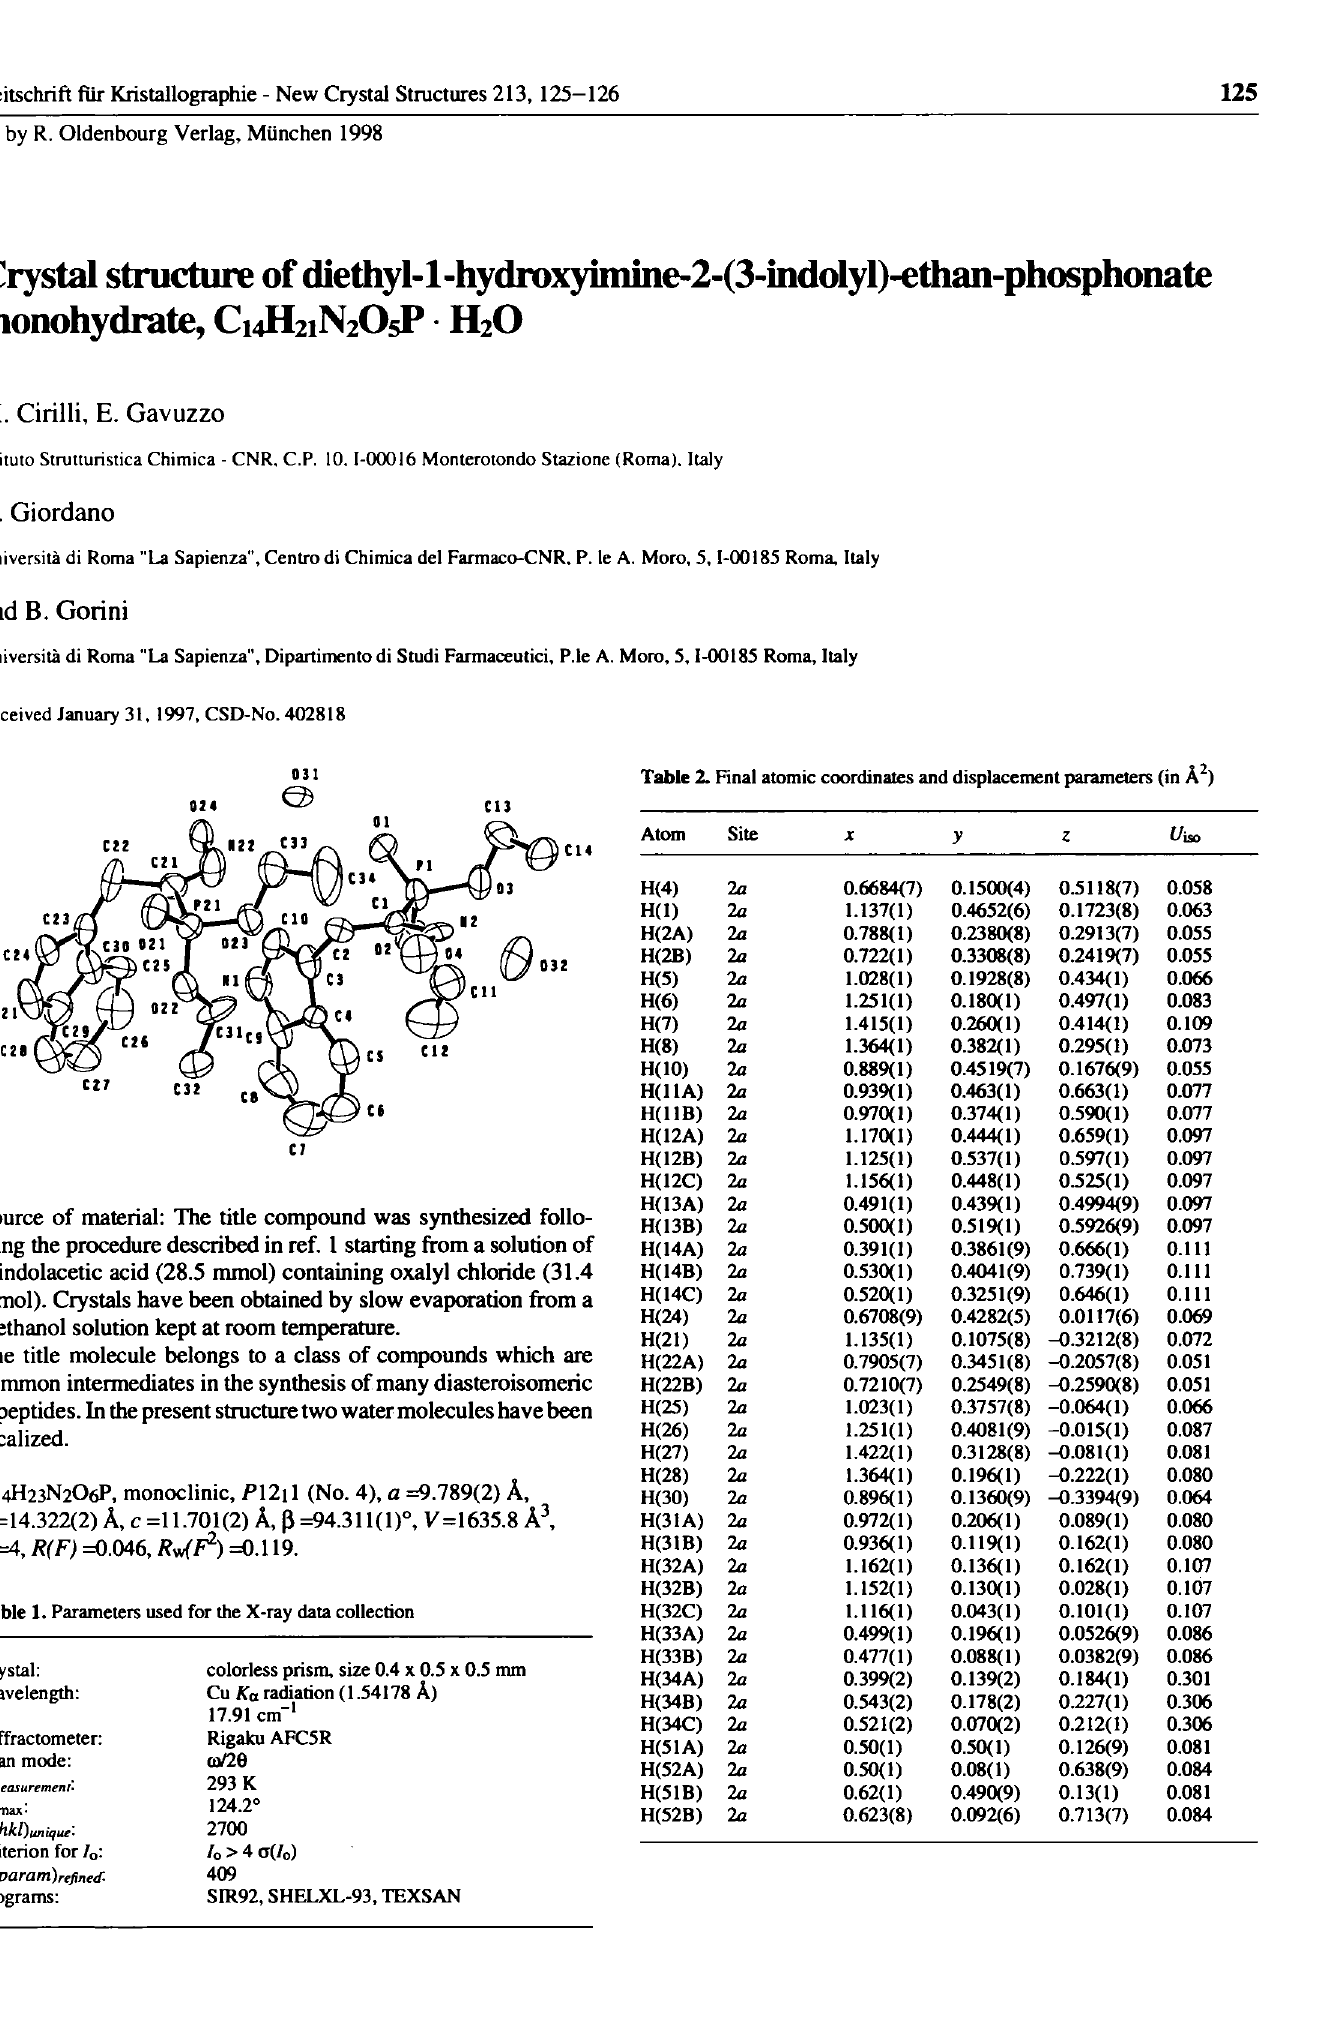
Table 1. Parameters used for the X-ray data collection Crystal: colorless prism, size 0.4 χ 0.5 χ 0.5 mm Wavelength: